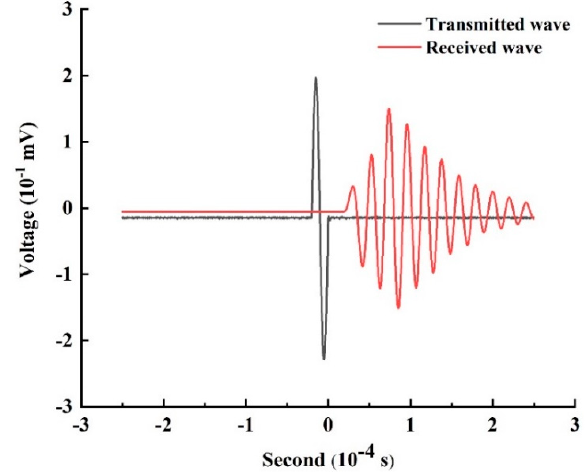
Figure 5. Transmitted and received waves.